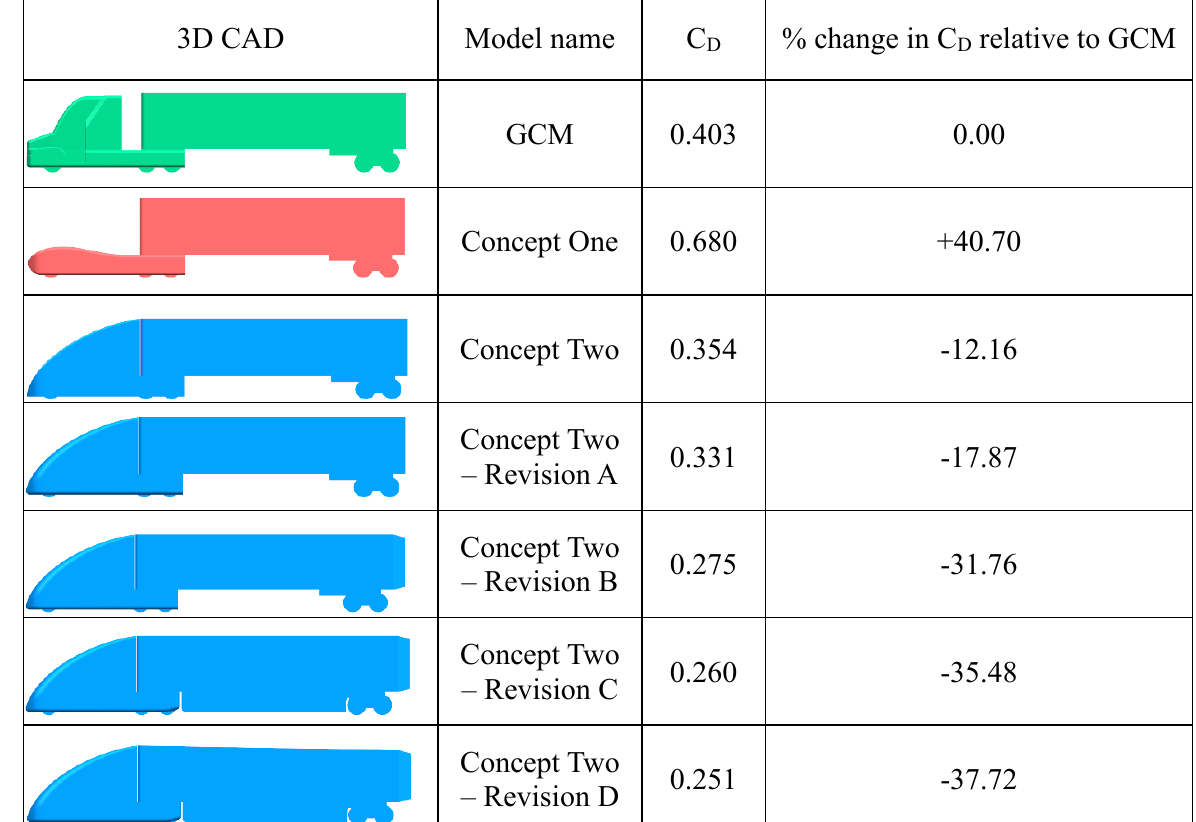
Comparison of C values for all CFD simulated D